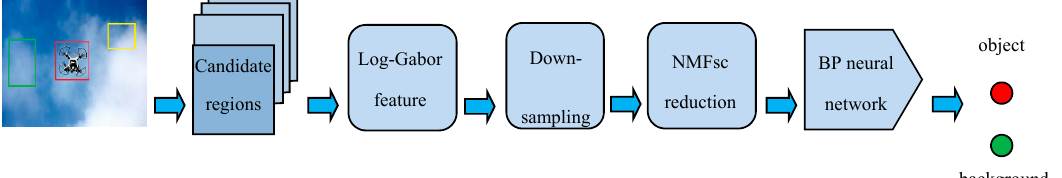
Figure 1. The flowchart of algorithm. NMFsc is non-negative matrix factorization (NMF) with sparseness constraint.